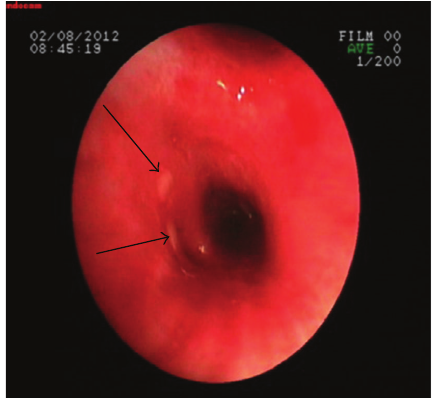
Figure 2: The fiberoptic bronchoscopy revealed a polypoid, necrotic endobronchial lesion in the left lower lob superior